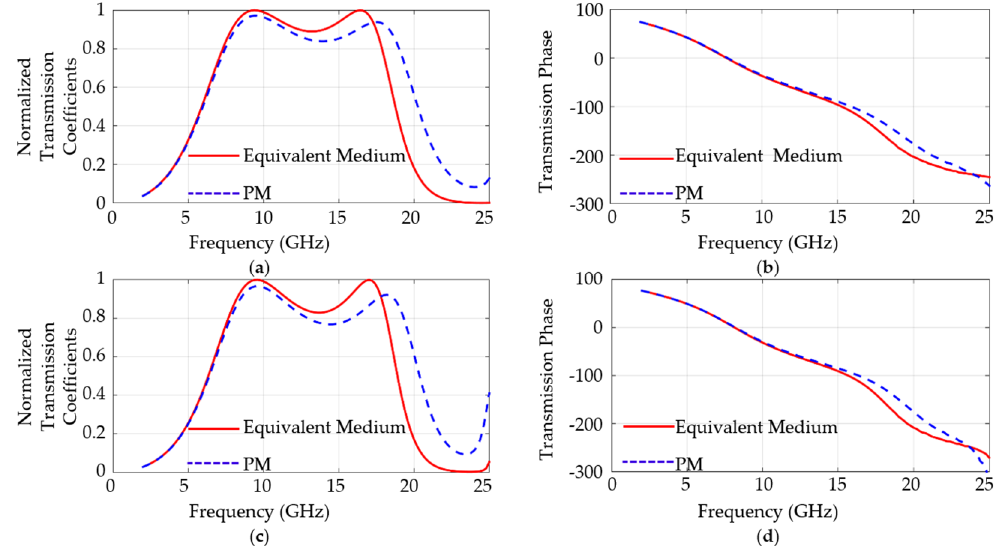
Figure 3. The transmission coefficients and transmission coefficients phase comparisons of different media and incident transverse electric (TE) waves: ( a ) Vertical incident normalized transmission coefficients; ( b ) vertical incident transmission coefficients phase; ( c ) 30 ◦ incident normalized transmission coefficients and ( d ) 30 ◦ incident transmission coefficients